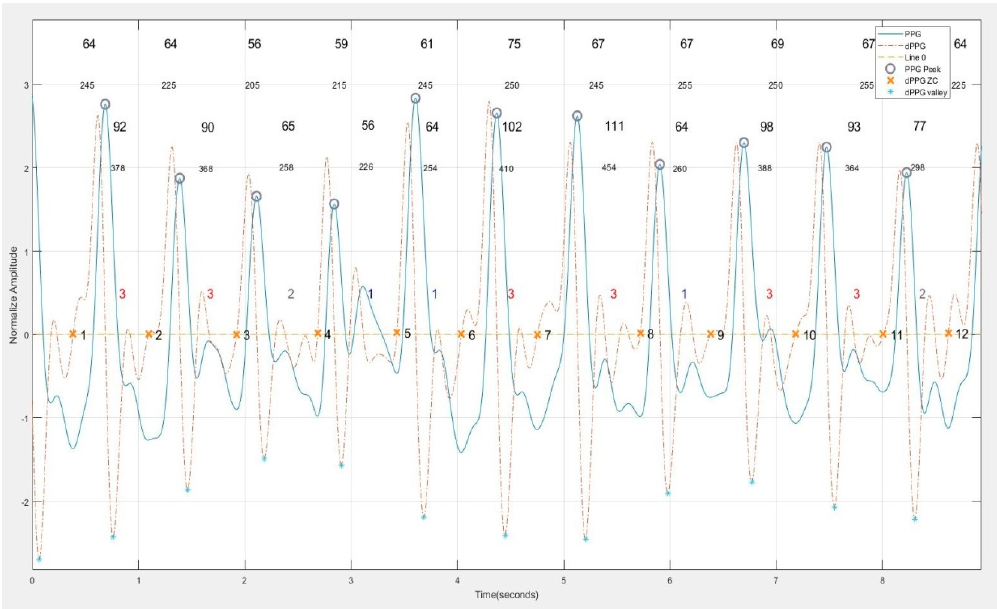
Figure 9. The PPG signal (solid line) and its differential signal (dashed line) for Subject 5, and his SVs and LVET measured with the medis ® CS 2000 and our ICG device.